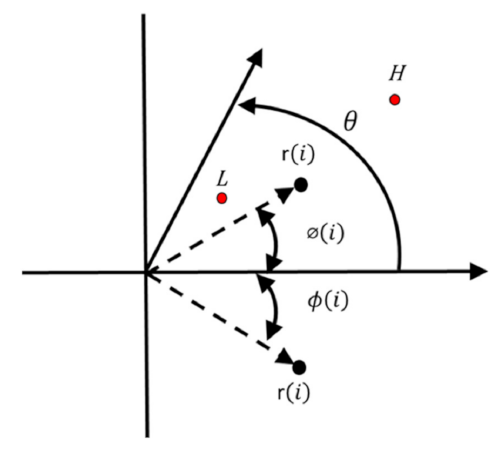
Figure 1. Symmetrized dot pattern